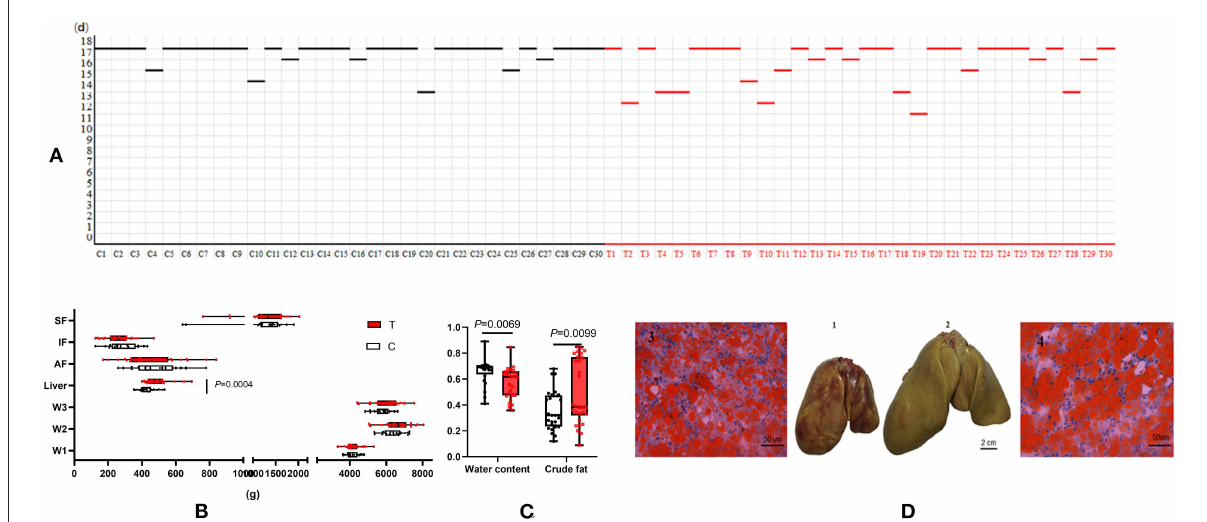
FIGURE1 Dietary supplementation of 10% fructose influenced overfed goose liver lipid accumulation. (A) Comparison of overfeeding time between control group and treatment group (the line represents the point of slaughter in time during an 18-day-long overfeeding period); (B) data between control group and treatment group ( n = 30) after slaughter; (C) comparison of liver water content and crude fat content between control group and treatment group ( n = 30); (D) comparison of livers and liver tissue sections between control group and treatment group ( n = 3). (1) Goose liver of control group after 18 days of overfeeding. (2) Goose liver of treatment group after 18 days of overfeeding. (3) Goose liver tissue section of control group after 18 days overfeeding (200 × ). (4) Goose liver tissue section of treatment group after 18 days overfeeding (200 × ). C, control group; T, treatment group; W1, body weight before overfeeding; W2, body weight after overfeeding; W3, slaughter weight; SF, subcutaneous fat; AF, abdominal fat; IF, intestine-mesentery